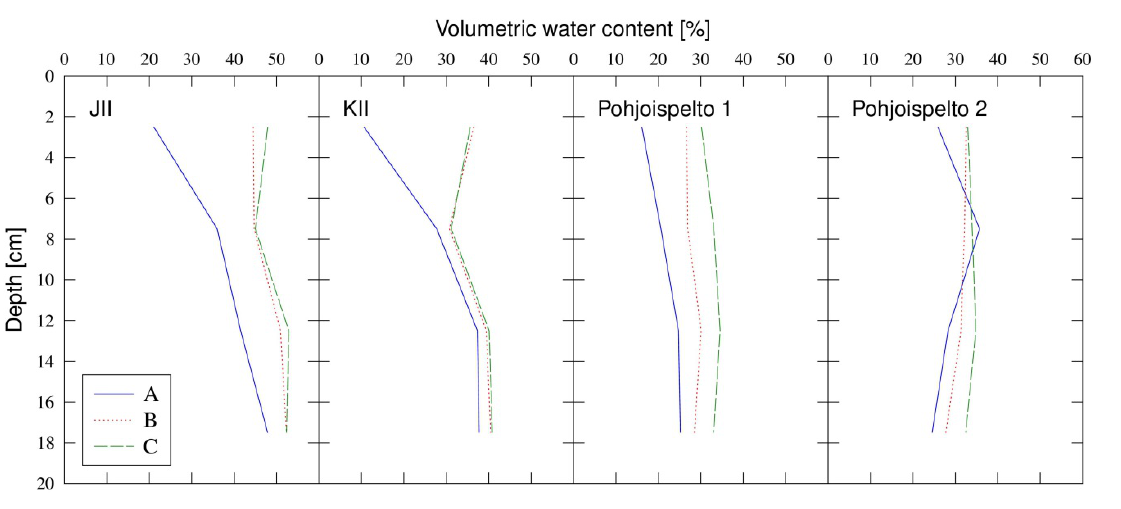
Fig. 5. Volumetric soil moisture content to 20 cm depth in fine-textured (JII, KII) and coarser-textured (Pohjoispelto 1 & 2) plots used for assessing the impacts of antecedent soil moisture on near-saturated hydraulic conductivity (K(h)). A = initial moisture status, B and C = moisture status after the first and second application of 20 mm water,